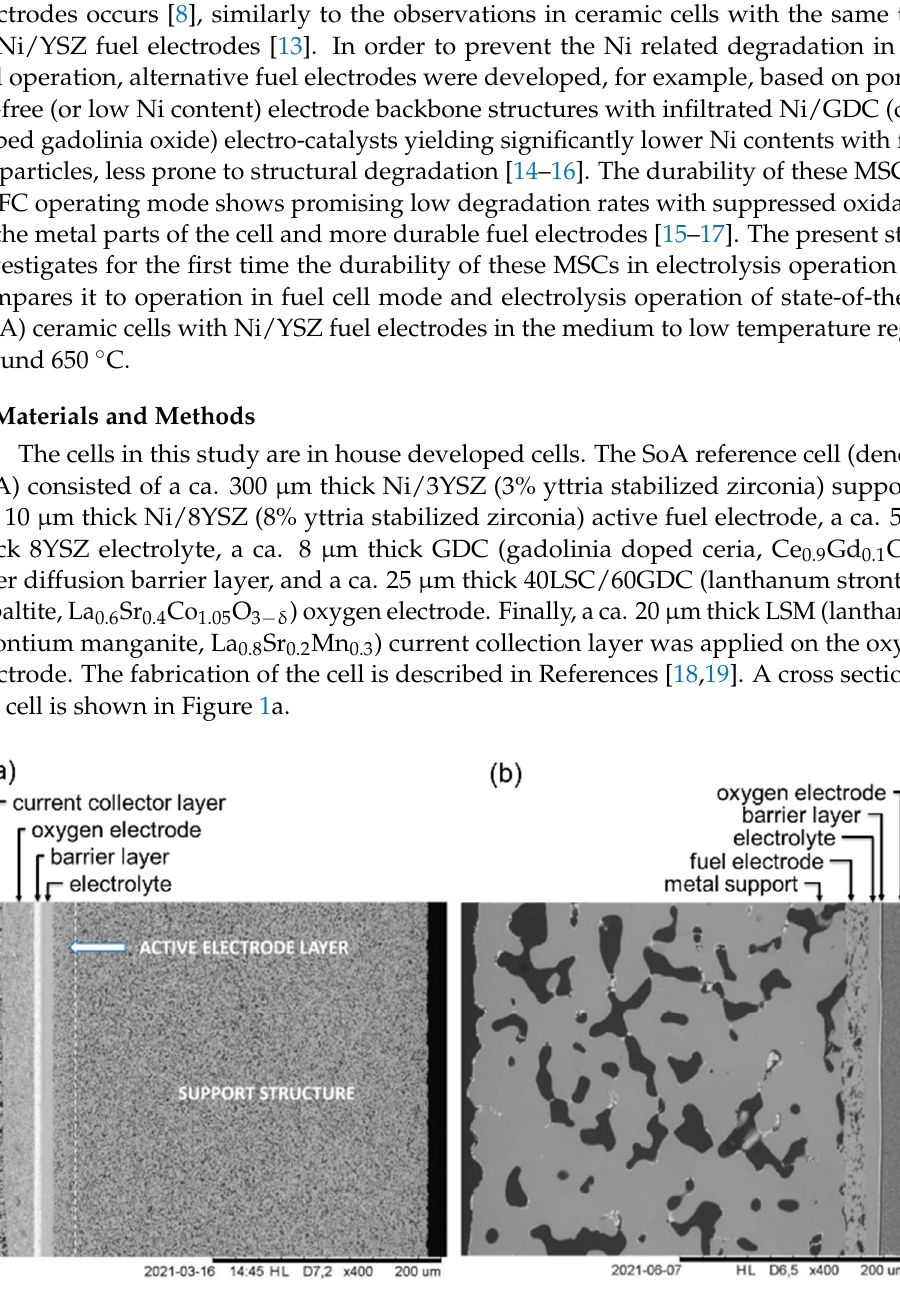
Figure 1. SEM image of the cross section of ( a ) SoA fuel electrode supported reference cell and ( b ) metal supported